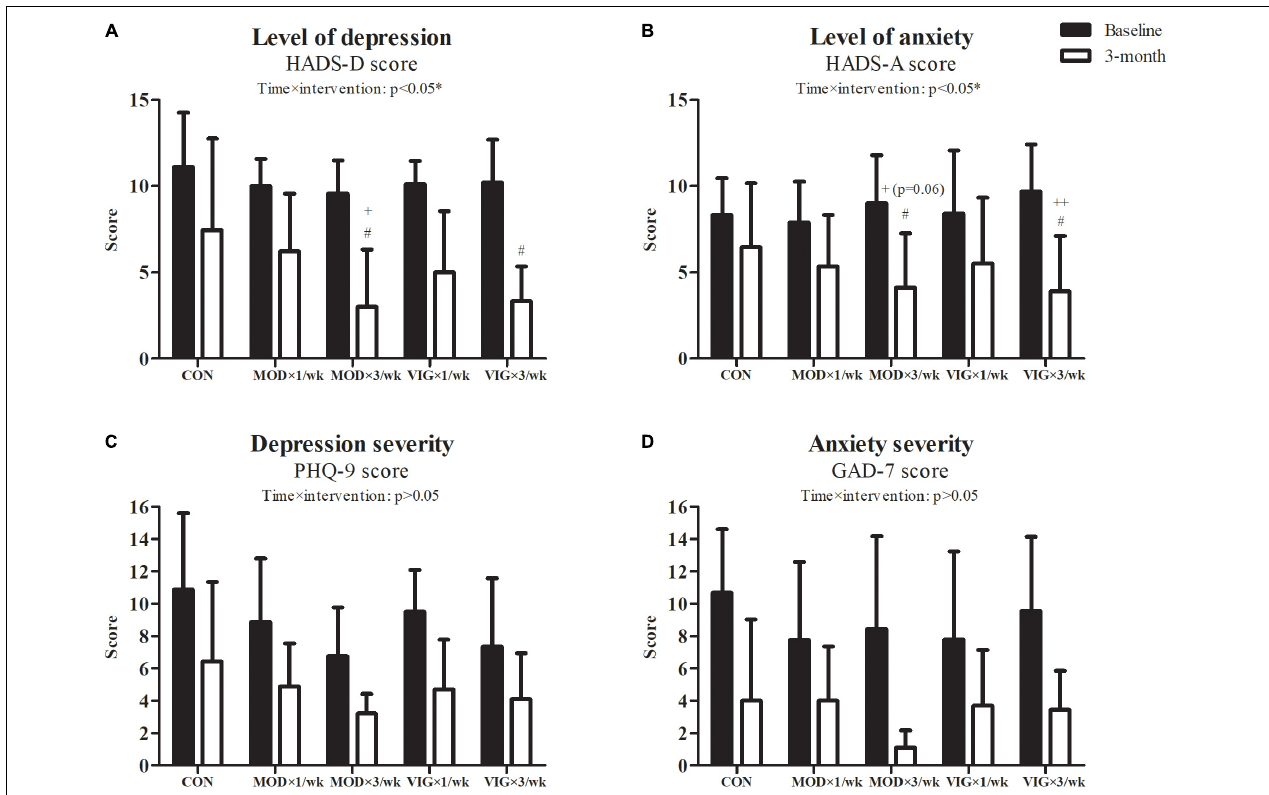
FIGURE 2 | Level of depression (A) , level of anxiety (B) , depression severity (C) , and anxiety severity (D) were examined at baseline and after the 12-week intervention. Control (CON; attention CON group) = one session of 75 min stretching exercise weekly, VIG × 3/week = three sessions of 25 min vigorous-intensity [6.5 metabolic equivalents of task (METs)] walking exercise weekly, MOD × 3/week = three sessions of 50 min moderate-intensity (3.25 METs) walking exercise weekly, VIG × 1/week = one session of 75 min vigorous-intensity (6.5 METs) walking exercise weekly, MOD × 1/week = one session of 150 min vigorous-intensity (3.25 METs) walking exercise weekly. # Significantly different from CON at the same time point. + Significantly different from MOD × 1/week at the same time point. ++ Significantly different from VIG × 1/week at the same time point.